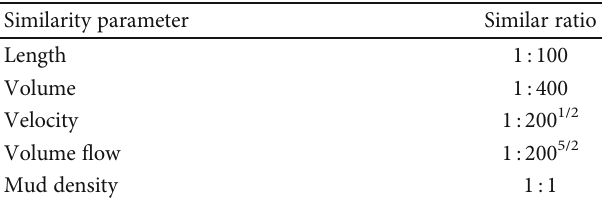
Figure 2: Schematic diagram of the deposition test. Table 3: Similar scale coe ffi cients of the dam